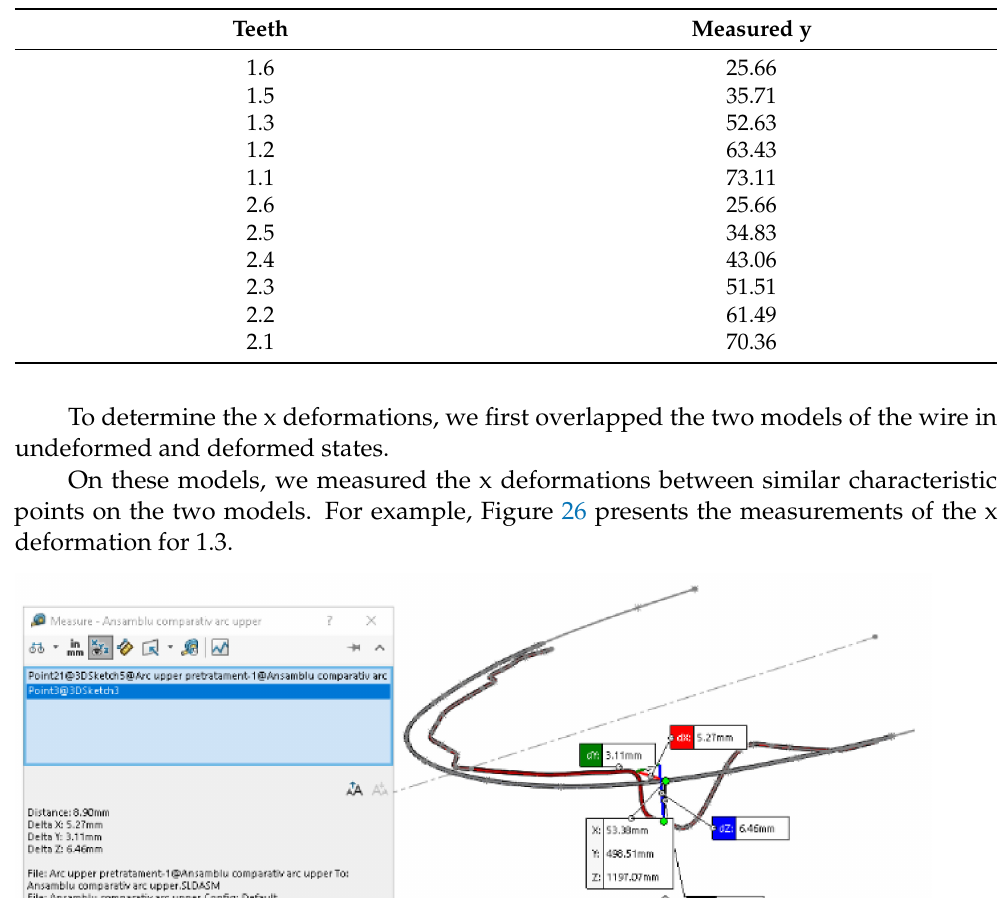
Table 7. Y coordinate values for the upper wire.